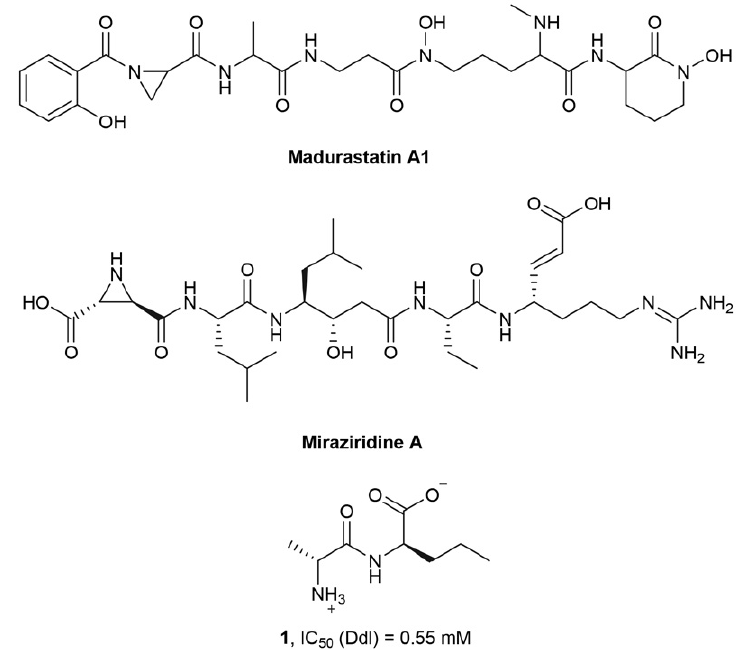
Figure 1. Natural products with aziridine ring and D-Ala:D-Ala ligase (Ddl) inhibitor 1 .